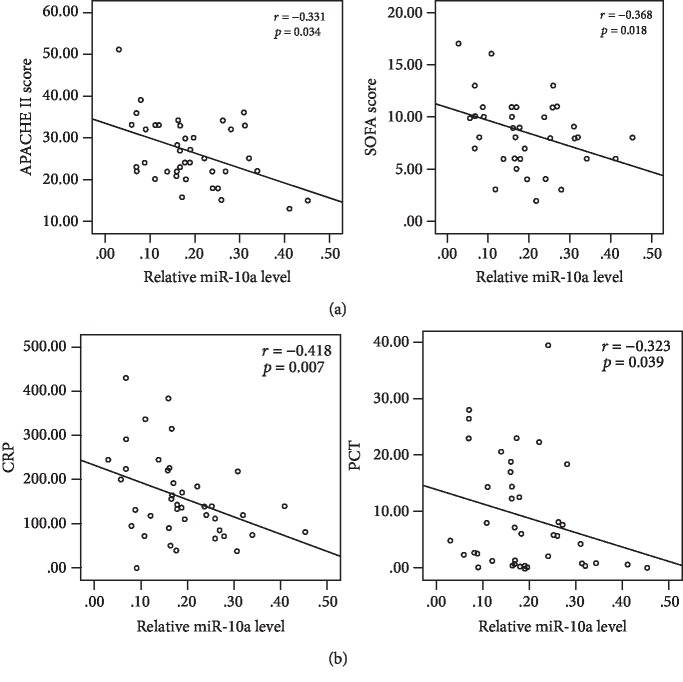
Correlation analysis of PBMC miR-10a levels with disease severity scores and sepsis biomarkers. (a) The curve was plotted by miR-10a relative expression values at admission of 41 sepsis patients to their respective APACHE II and SOFA scores. (b) The curve was plotted by miR-10a relative expression levels at admission to their respective CRP and PCT values. Each circle represents an individual patient.